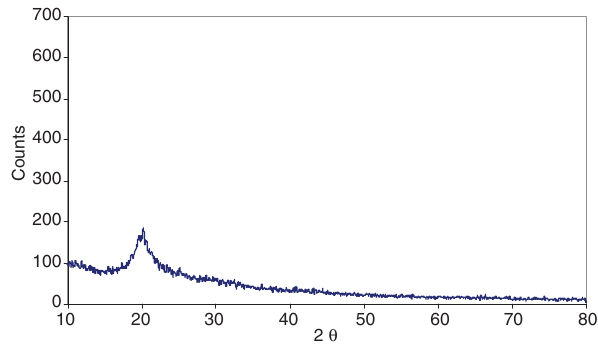
Figure 1 X-ray diffraction of polyvinyl alcohol.